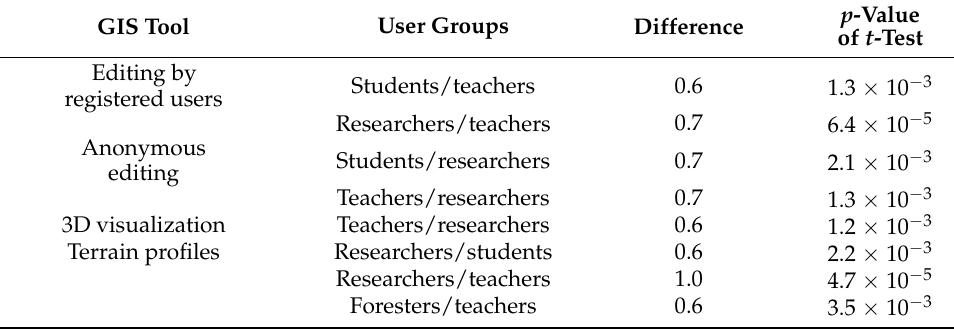
Table A8. Significant differences in GIS tool ratings by user